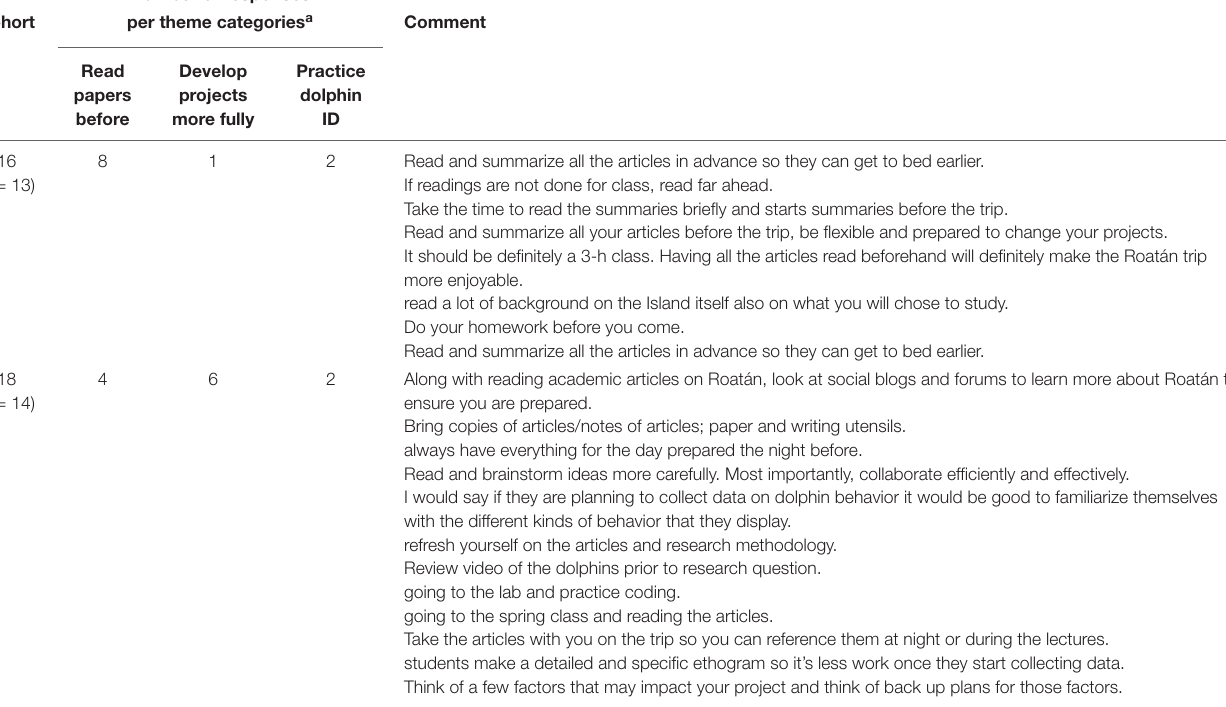
TABLE 2 | Summary of themes and comments produced by field study students regarding preparing for the field